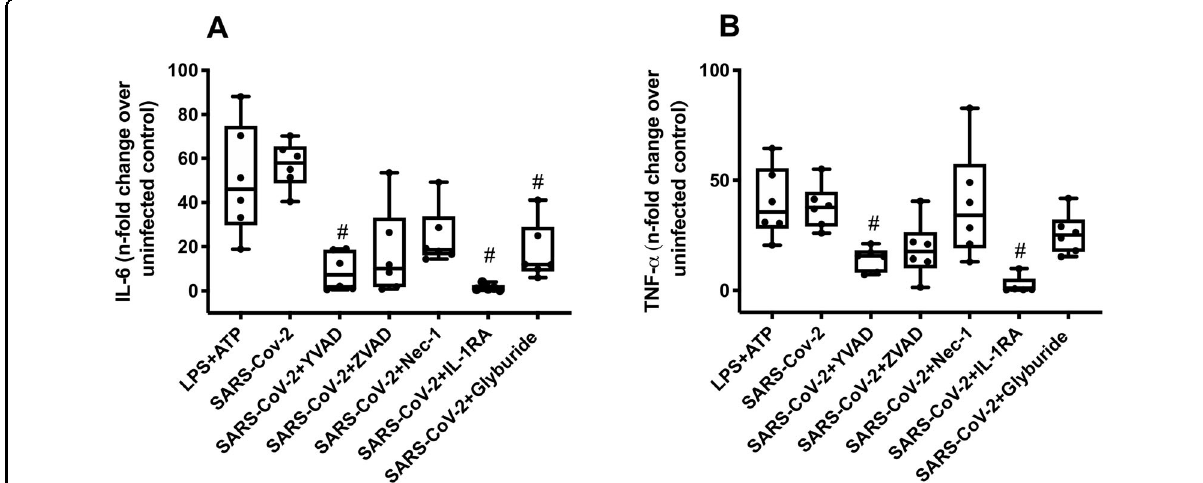
Fig. 3 Caspase-1- and IL-1 receptor-dependent ampli fi cation pro-in fl ammatory cytokines secretion in SARS-CoV-2-infected monocytes. Human monocytes were pharmacologically treated to impair the function of caspase-1 (AC-YVAD-CMK; 1 µM), pan-caspase (ZVAD-FMK; 10 µM), RIPK (Nec-1; 25 µM), IL-1ß receptor (IL-1RA; 1 µM), or NLPR3 (glyburide 100 µM) since 1 h prior to infection at MOI of 0.1 with SARS-CoV-2. Monocytes were stimulated with LPS (500 ng/mL) for 23 h and after this time were stimulated with ATP (2 mM) for 1 h as a positive control. Cell culture supernatants were collected for the measurement of the levels of A IL-6 and B TNF- α . Graphs data are representative of six independent experiments. Data are presented as the mean ± SEM # P < 0.05 versus infected and untreated